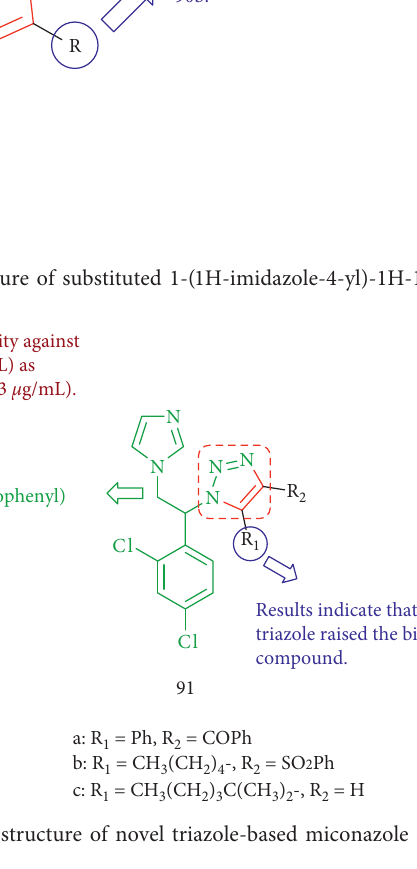
The presentation of OCH group in phenyl ring 3 decreased the fungicidal activity of compound 90b.